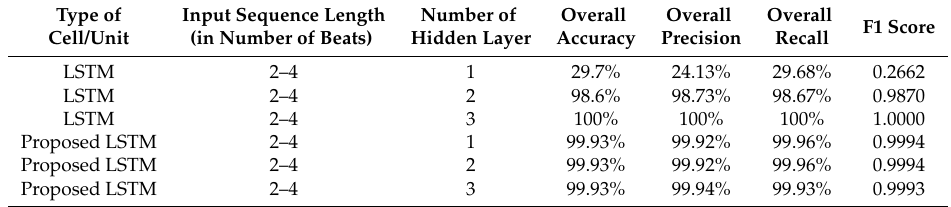
Table 4. Performance summary of the proposed bidirectional LSTM in NSRDB analysis 1 of Figure 8a.